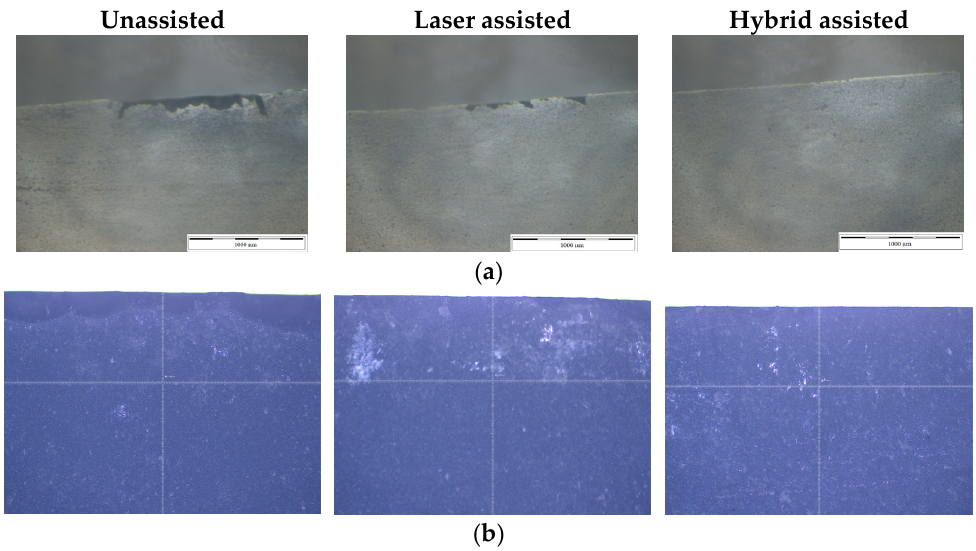
Figure 12. Validation experimental results at n = 12,000 rpm, a e = 0.02 mm, and F = 500 mm/min for ( a ) surface morphology and ( b ) edge morphology for unassisted, laser-assisted, and hybrid-assisted systems.